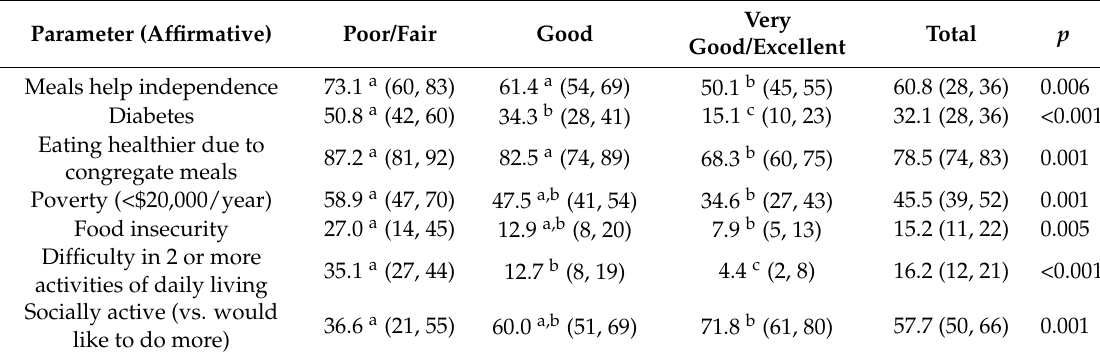
Table 5. Significant differences in health-related characteristics and self-rated